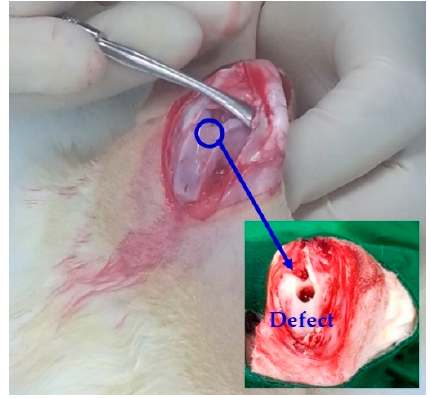
Figure 1. Optical image of the defect created in the femoral condyle of the rabbit.